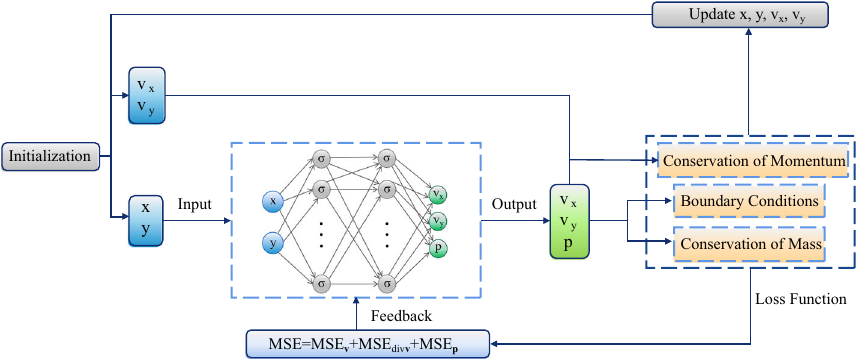
Fig. 2 Schematic of the PINN for the simulation of the landslide surge propagation process